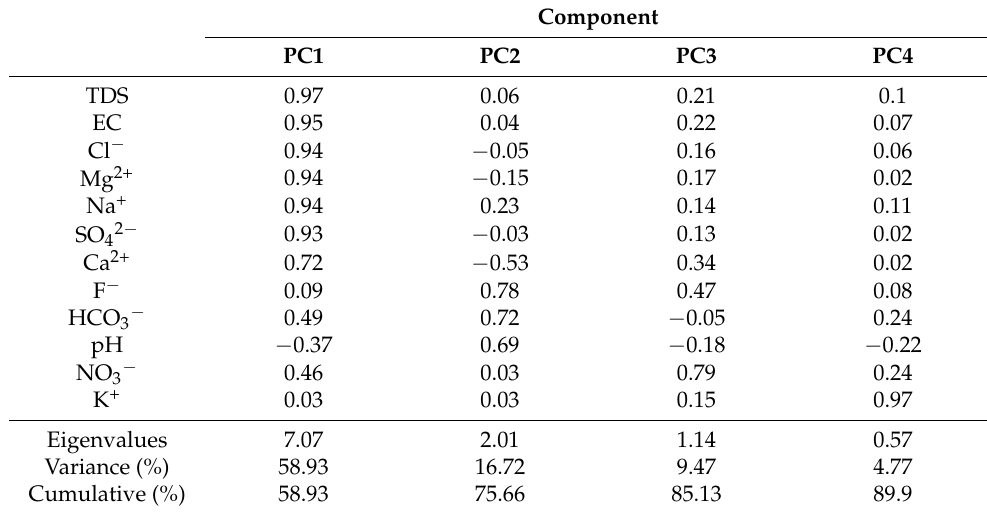
Table 2. Rotated Component Matrix of PCA